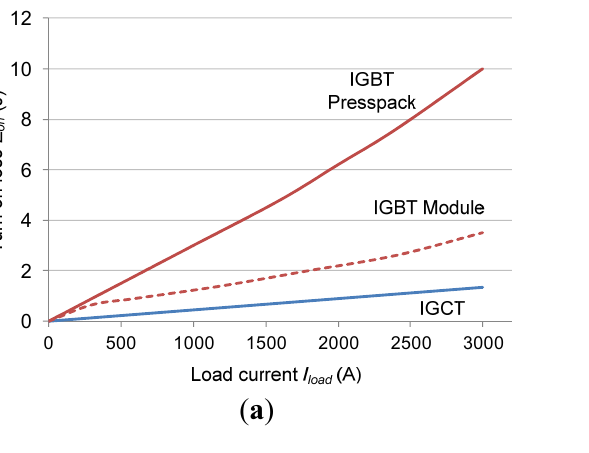
Figure 4. Normalized switching loss profiles for switches (recommended test conditions, 125 °C). ( a ) Turn on switching loss E